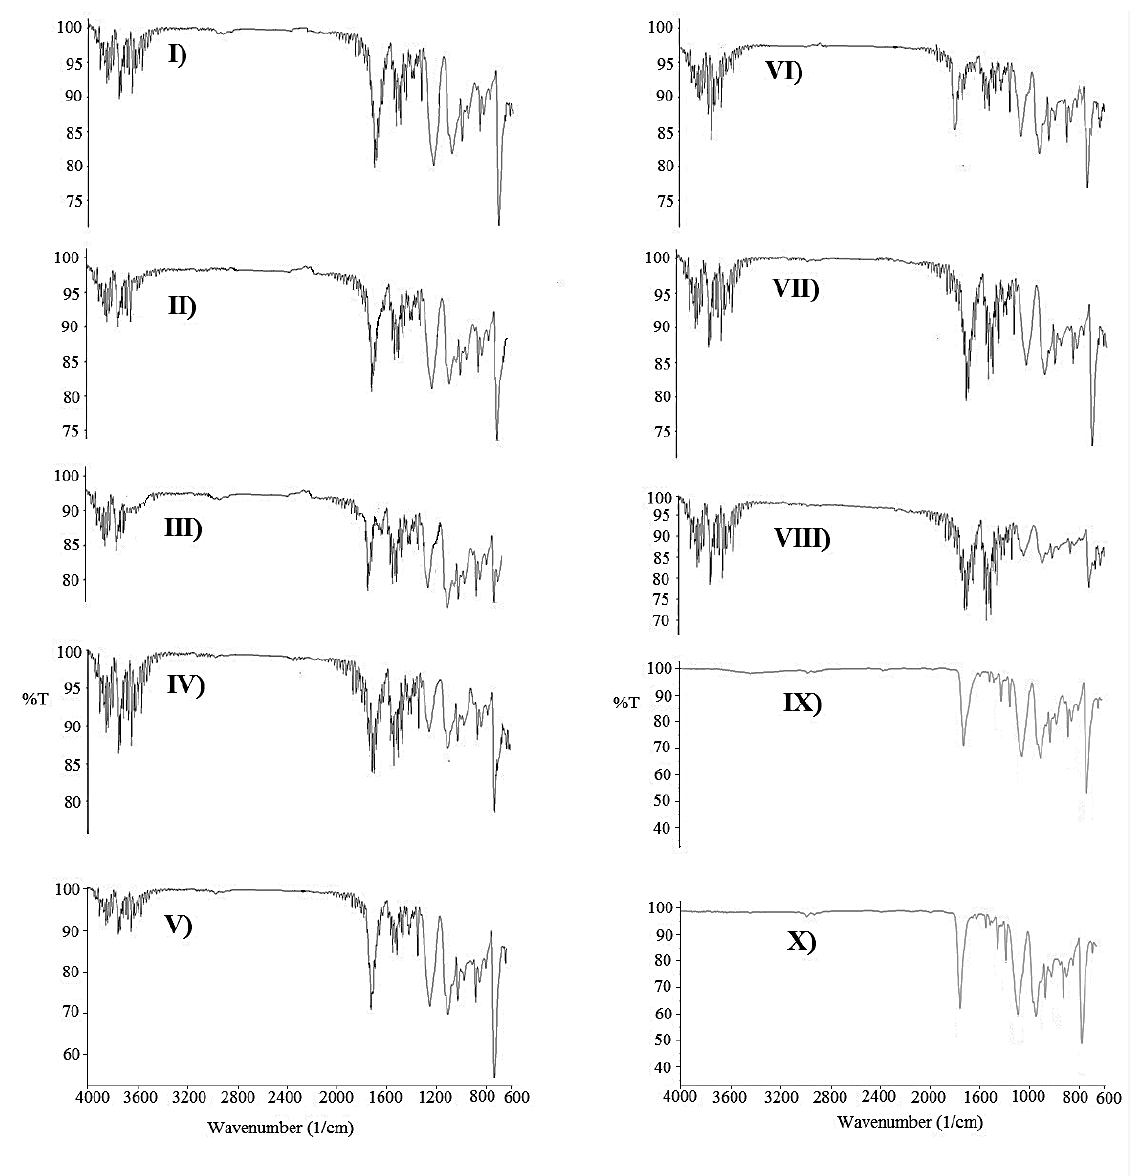
FIGURE 5.3 - FTIR spectra of I) 30% PEG with pure drug loaded patch; II) 40% PEG with pure drug loaded patch; III)